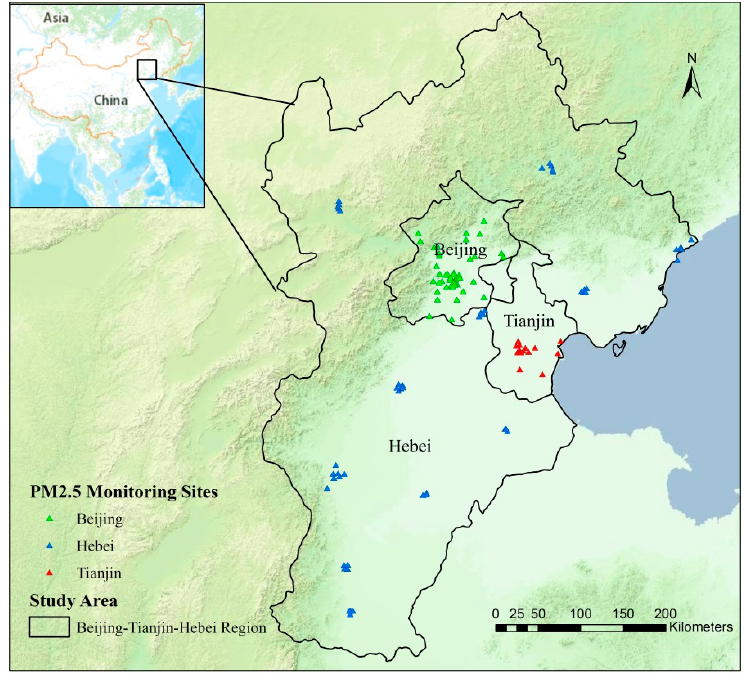
Figure 1. Study area and locations of PM 2.5 monitoring stations.